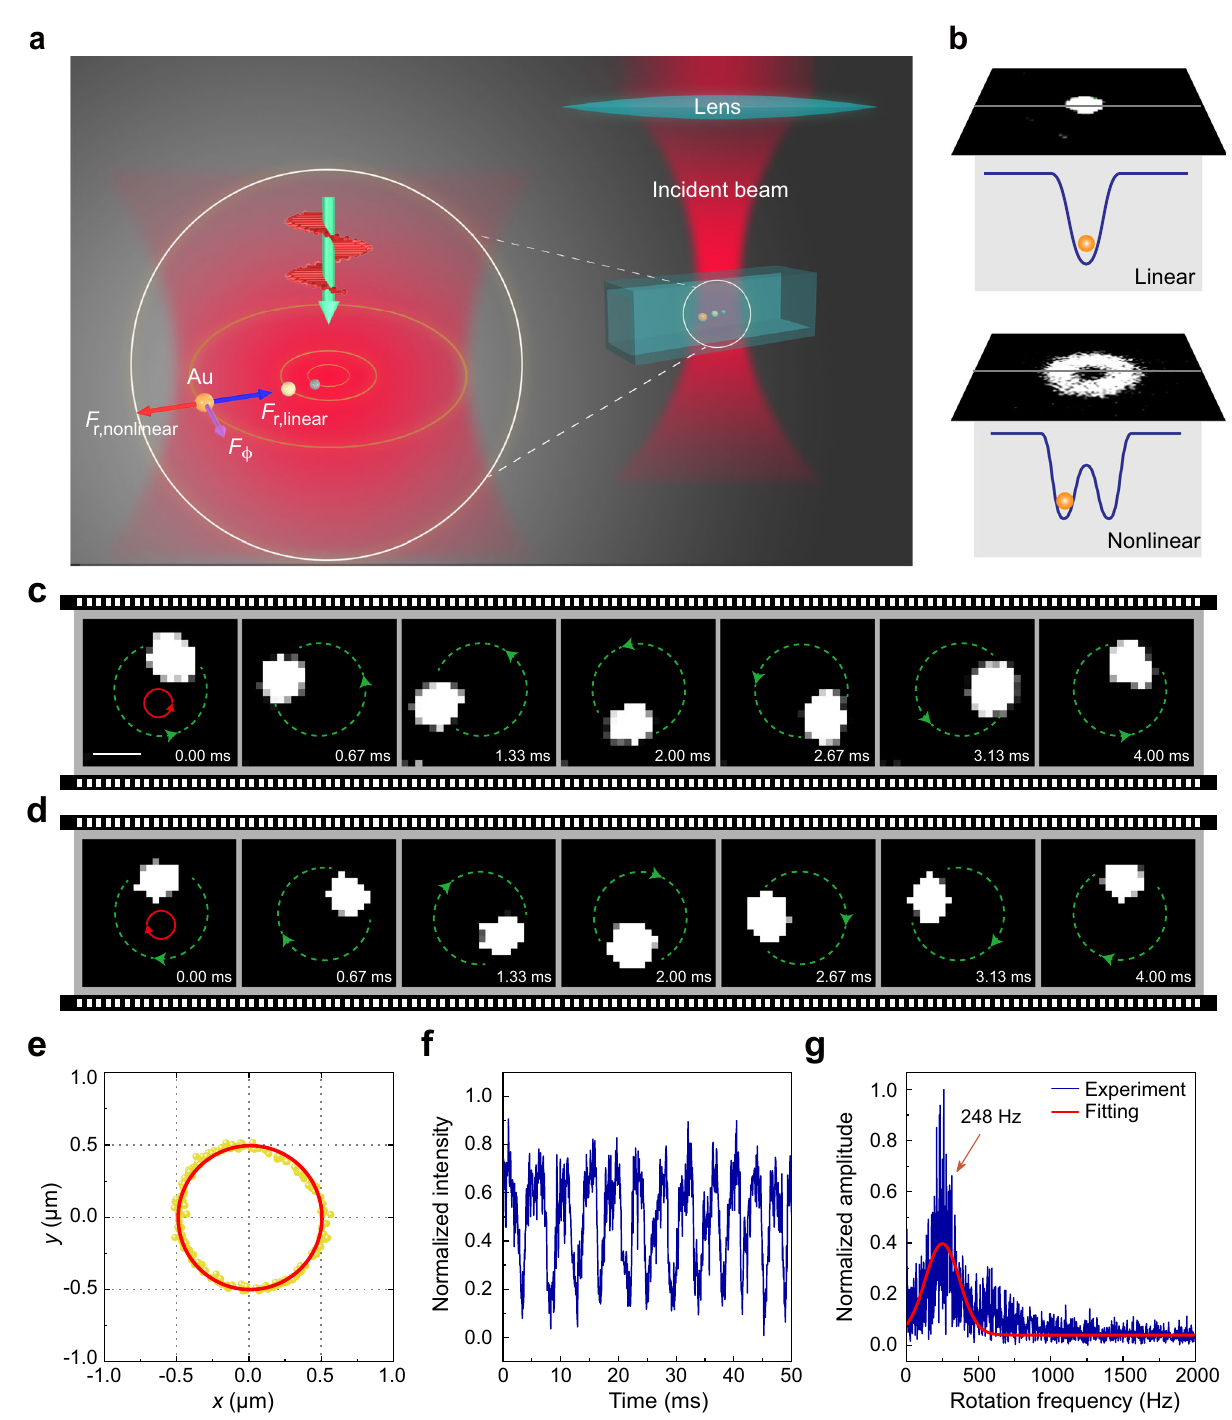
Fig. 1 Illustration of the setup and typical experimental results for the movement trajectory of the trapped nonlinear particle. a Schematic of nonlinear nanoparticle (e.g., gold (Au), silver (Ag)) trapped by a circularly polarized Gaussian laser beam. b Image of the scattering light from the nonlinear gold nanoparticle (GNP) shows that the GNP was trapped in a ring shape potential well, when the incident beam was switched from continuous mode to femtosecond mode. c , d Successive frames of a movie recording, which show the rotation of a GNP trapped by a circularly polarized femtosecond laser with right handedness and left handedness, respectively. Images were taken by a CMOS camera at 1500 frames/s; green lines and arrows indicate the direction of GNP motion. Red arrows indicate the direction of handedness of circular polarization. The length of the white scale bars in all fi gures is 0.5 μ m. e 2-D trajectory projection of an orbiting particle in the transverse plane recorded by front-side-view imaging system. f The intensity of the scattering light from the rotation particle is measured by the photomultiplier tube (PMT). g The Fourier transformation of the scattering intensity signal shows the rotation frequency. In Fig. 1b – g, the mean power P of trapping laser beam is about 630 mW, NA value of the trapping lens is